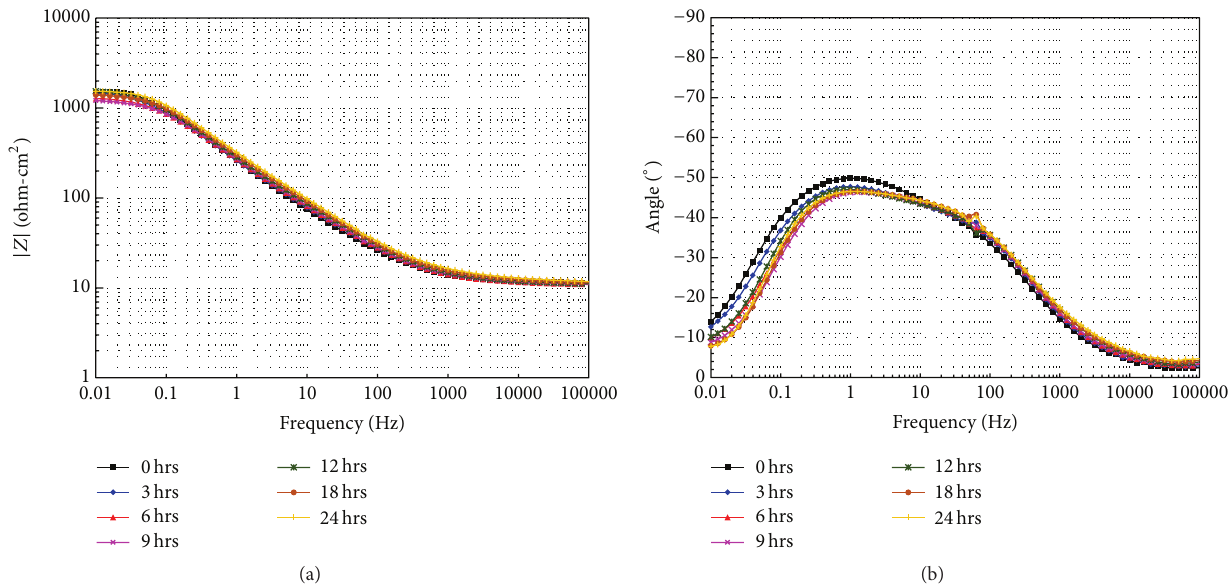
Figure 8: Bode plots for 40Nd magnet tested in 3.5% NaCl solution at 25 ∘ C for 24